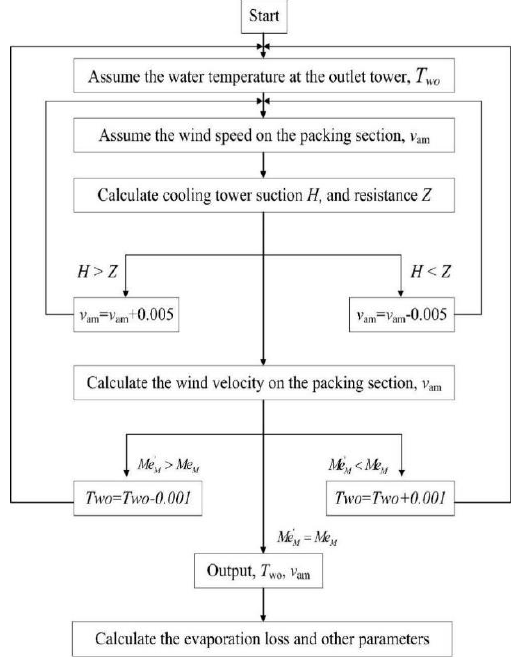
Figure 2. The flowchart of the evaporation loss in NDWCT.